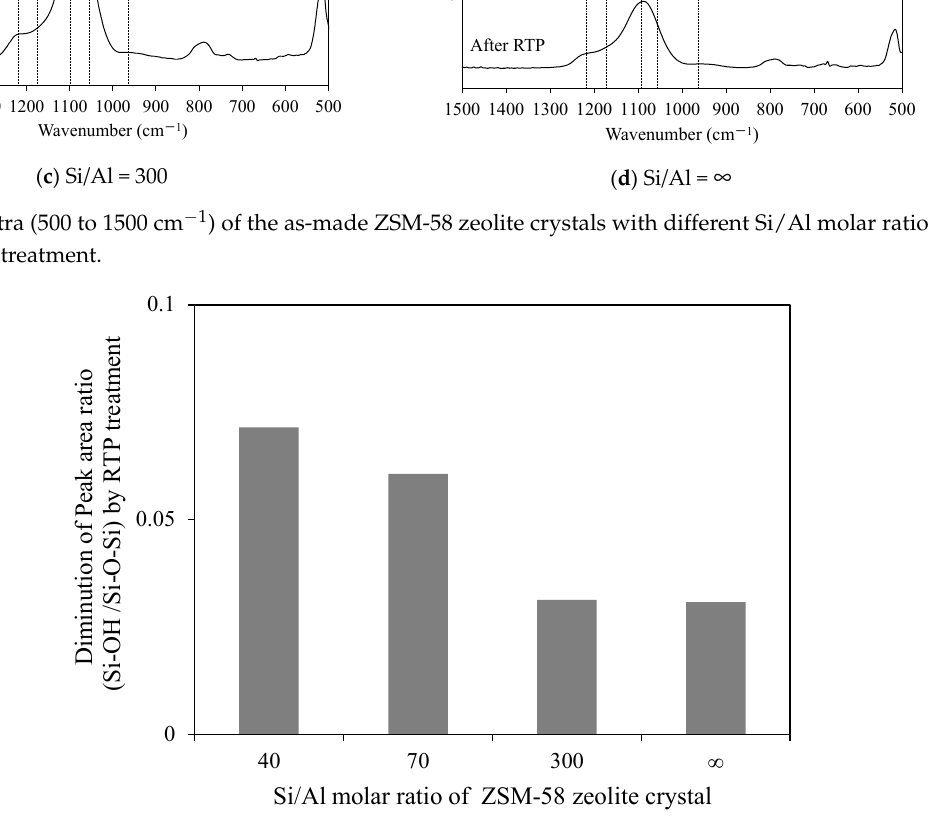
Table 4. Synthesis conditions and peak area ratios of silanol concentrations of ZSM-58 crystals with different Si/Al molar ratios with the measured FTIR spectra.